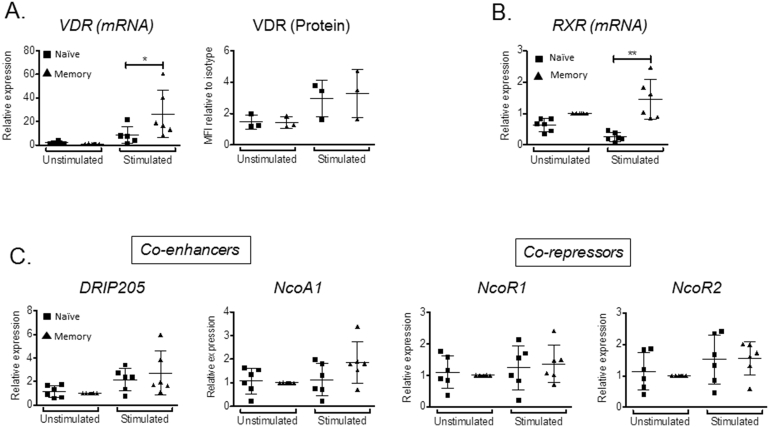
Memory and naïve T cells express similar levels of vitamin D response machinery. RNA was purified from naive and memory CD4+ T cells from the peripheral blood of healthy controls before and after stimulation with antiCD3/CD28 beads. Regulators of response to 1,25(OH)2D3 including (A) Vitamin D receptor (VDR), (B) Retinoid X Receptor (RXR), (C) VDR co-regulators: DRIP205, NcoA1, NcoR1 and NcoR2 were measured by qPCR. mRNA expression for each gene is shown relative to matched memory T cells. VDR protein in T cells was also measured by flow cytometry before and after stimulation with PMA and ionomycin. Stimulated T cells were defined as CD69+. Statistical significance was tested by repeated measures two-way ANOVA. * = P < 0.05, ** = P < 0.01.